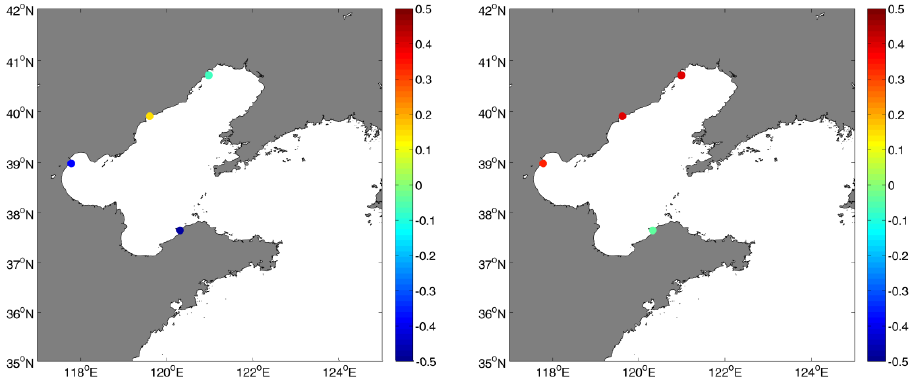
Figure 7. Correlations between storm surge intensity and the AO ( left ); and correlations between storm surge intensity and SH ( right ).